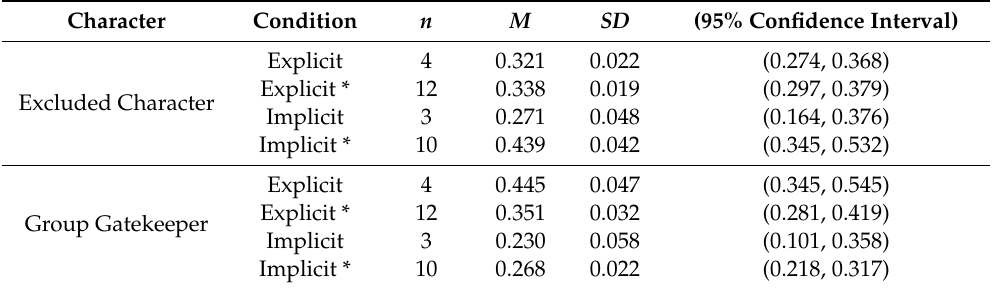
Table 1. Mean proportions of fixations on primary areas of interest (AOIs) during exclusion